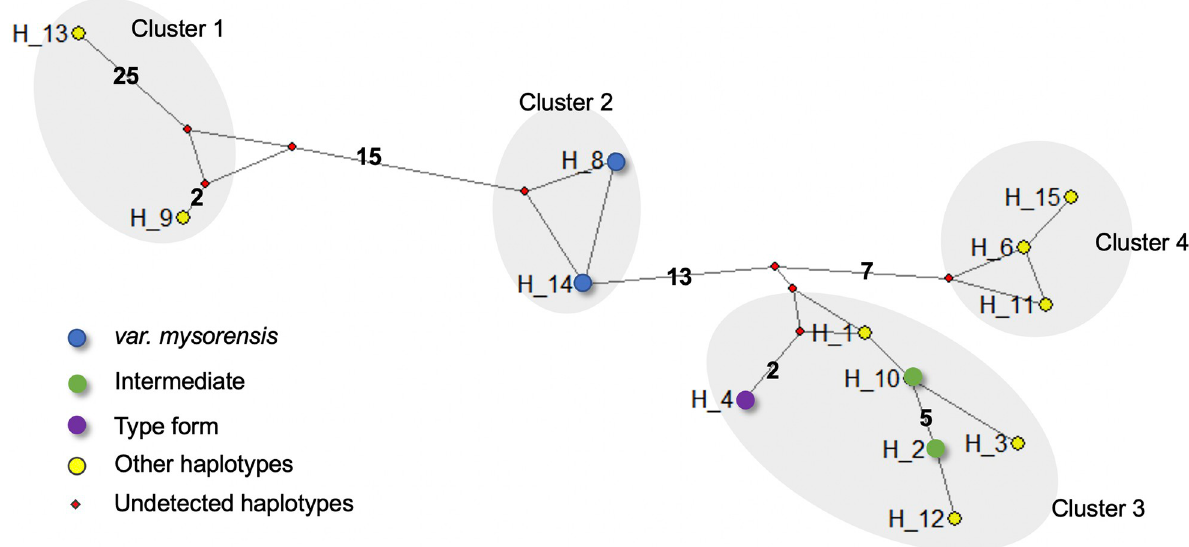
Fig 2. Haplotype network based on the AsteObp1 intron 1 sequences of An . stephensi . Median-joining network was constructed using NETWORK 10.2. Nodes represent haplotypes (assigned as markers for biological form, other haplotypes and undetected haplotypes). Numbers shown on the branches (except one step mutations) represent the numbers of mutations separating each